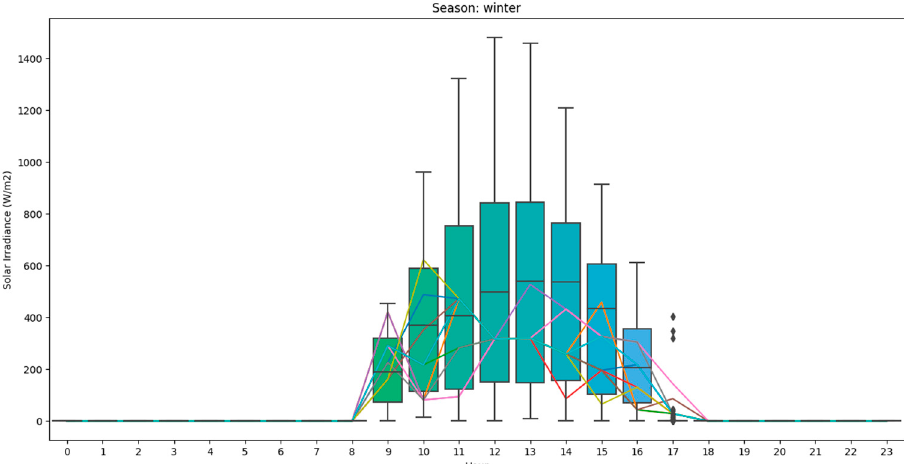
irradiance for the days in July from 2005 to 2016. Different line colors represent different scenarios